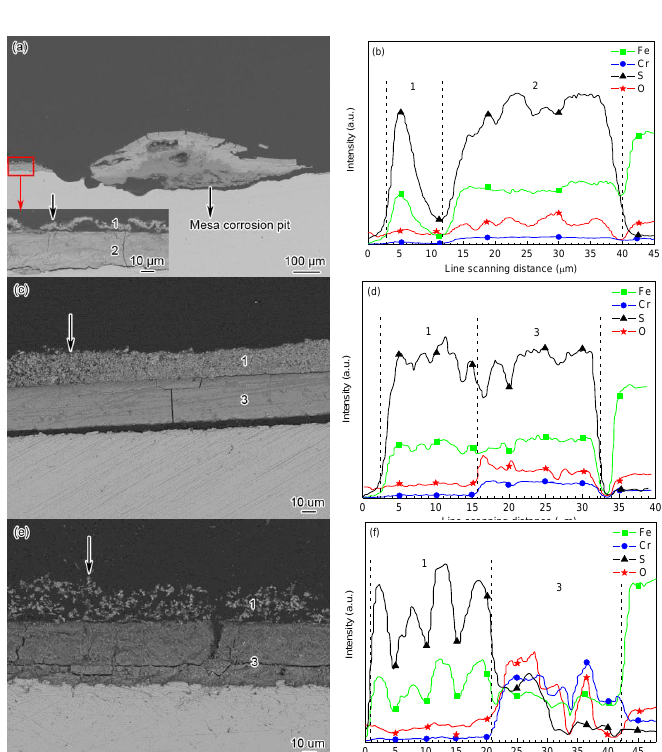
Figure 8. ( a , c , e ) cross-sectional backscattered electron images and ( b , d , f ) elemental distributions in cross-sections of the corrosion scales on (a,b) P110; (c,d) 3Cr-P110, and (e,f) 5Cr-P110 tube steels: (b) denoted by arrow in (a); (d) denoted by arrow in (c) and (f) denoted by arrow in (e) (1—FeS 1− x ; 2—FeS 1− x + FeCO 3 and 3—FeS 1− x + Cr(OH) 3 + FeCO 3 ).